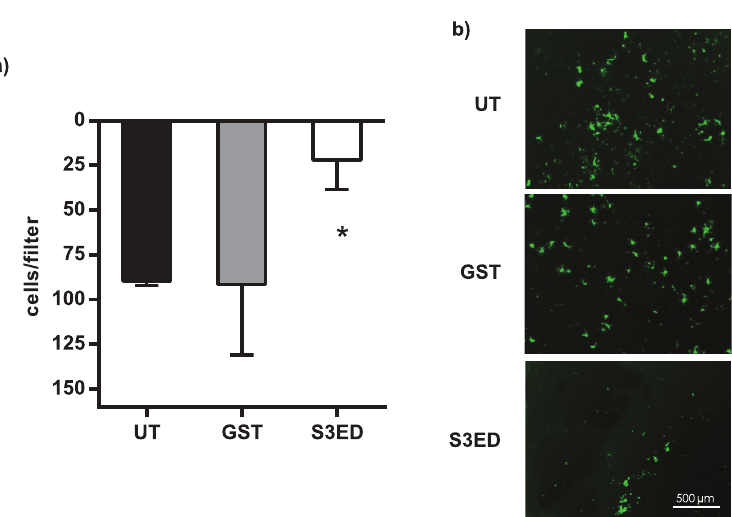
Figure 6. S3ED inhibits EC invasion into Collagen I. 5 × 10 3 sEND cells were seeded on 10 µl of Collagen I and were allowed to migrate for 6 hours. Numbers of transmigrated cells are shown in ( a ) and micrographs of transmigrated Calcein-labelled cells are in ( b ). Error bars represent SD. One-way ANOVA with Bonferroni multiple comparisons was used to compare S3ED to relative UT control.